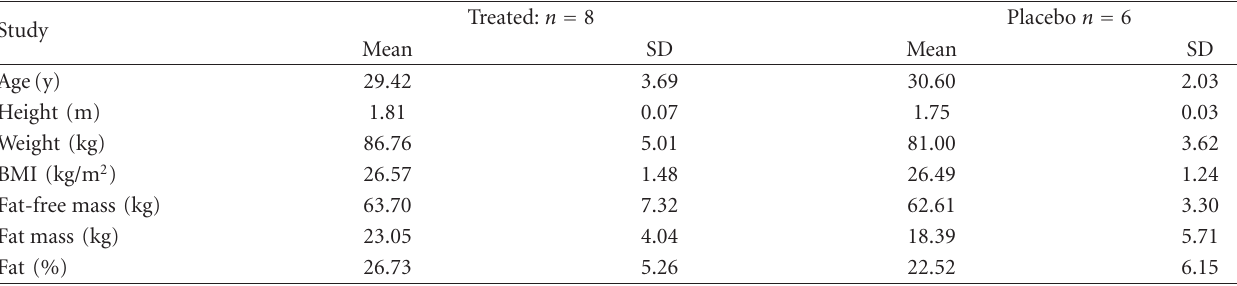
Table 1: Physical characteristics of ephedrine study subjects.